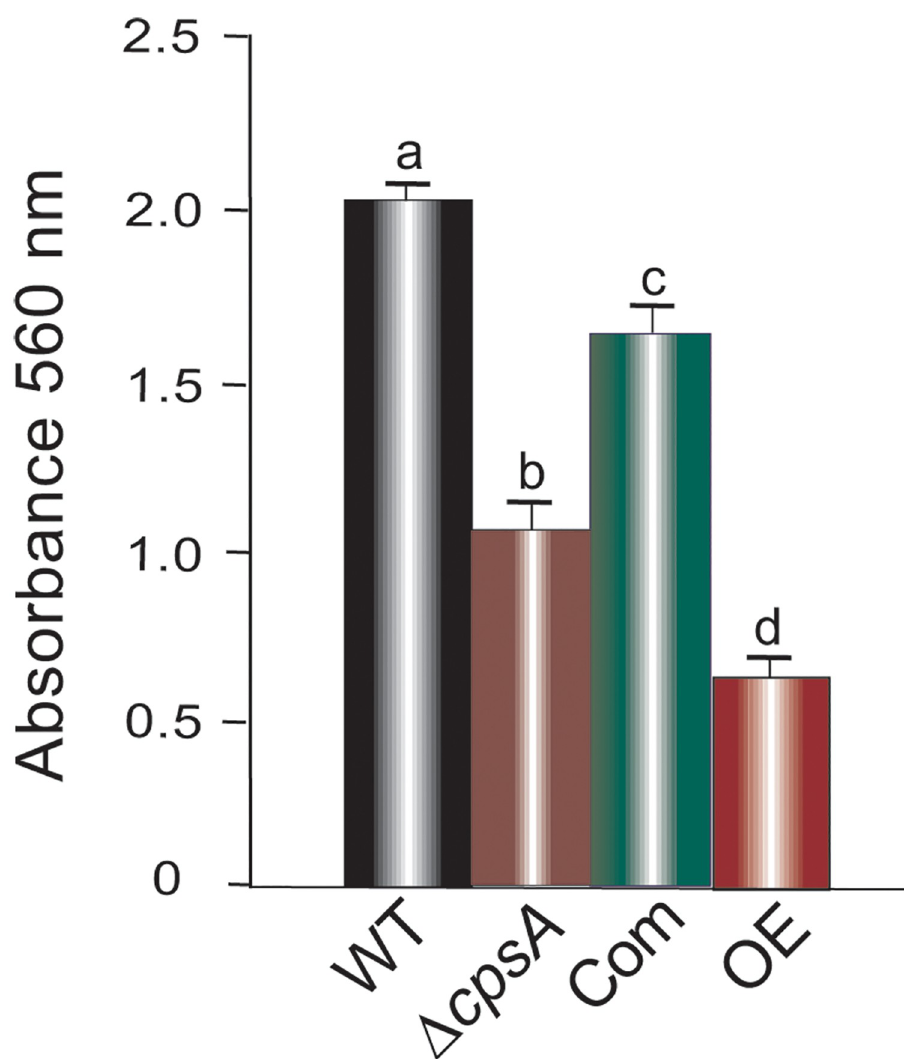
Fig 4. cpsA affects adhesion capacity. Liquid GMM (130 μ l) where inoculated with 10 6 spores/mL of wild type, Δ cpsA , Com and OE strains in individual wells of a Polystyrene 96-well culture plate. Twenty-four wells were used per strain. Mycelium was stained with Crystal violet as described in Materials and Methods section. The plate was incubated at 37˚C for 24 h. The bar graph represents the average OD for each strain measured at 560 nm. The error bar represents the standard